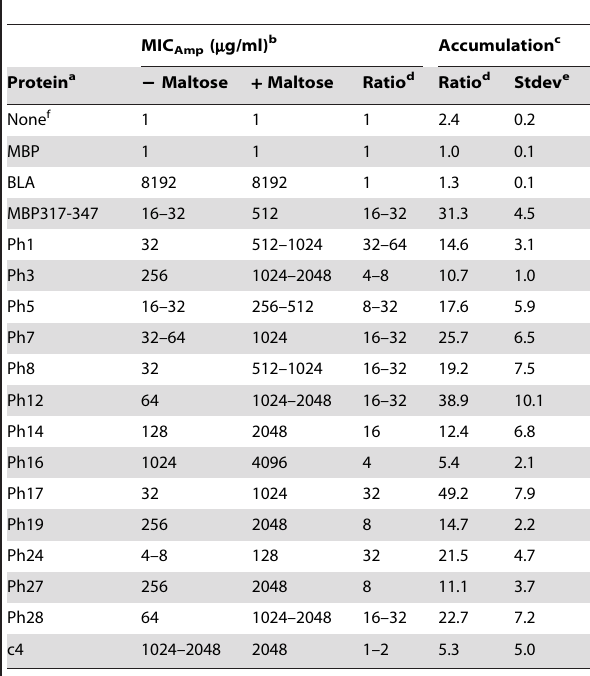
Table 2. The effect of maltose on MIC Amp and protein expression.